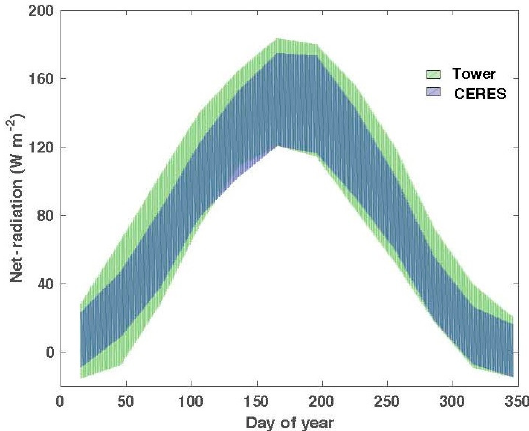
Figure 6. Comparison of monthly CERES net-radiation with measurements. Only CERES cells that had three or more towers sites within their boundaries were